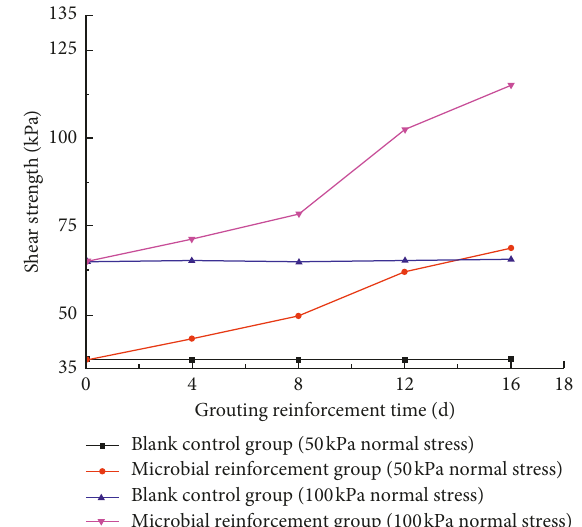
Figure 11: The changes in shear strength of uranium tailings reinforced by MICP as function of time.